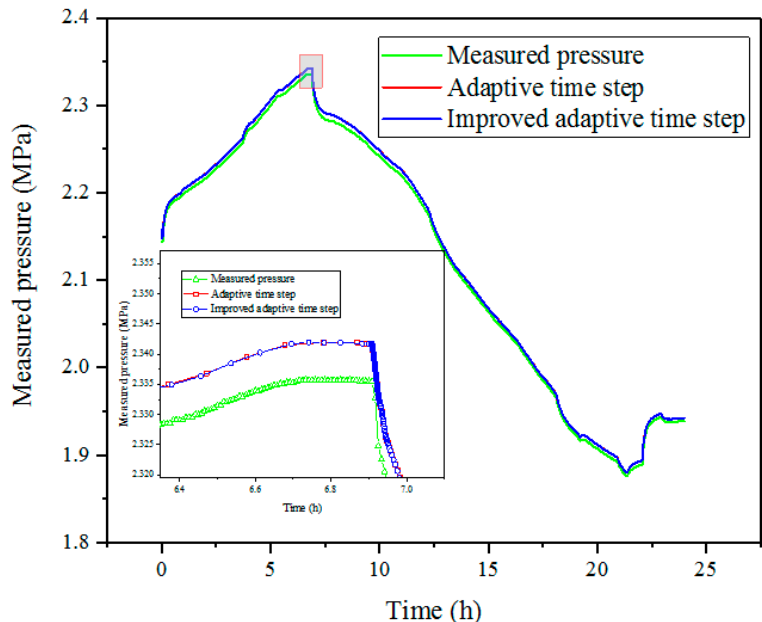
Figure 7. The pressure at outlet versus time.